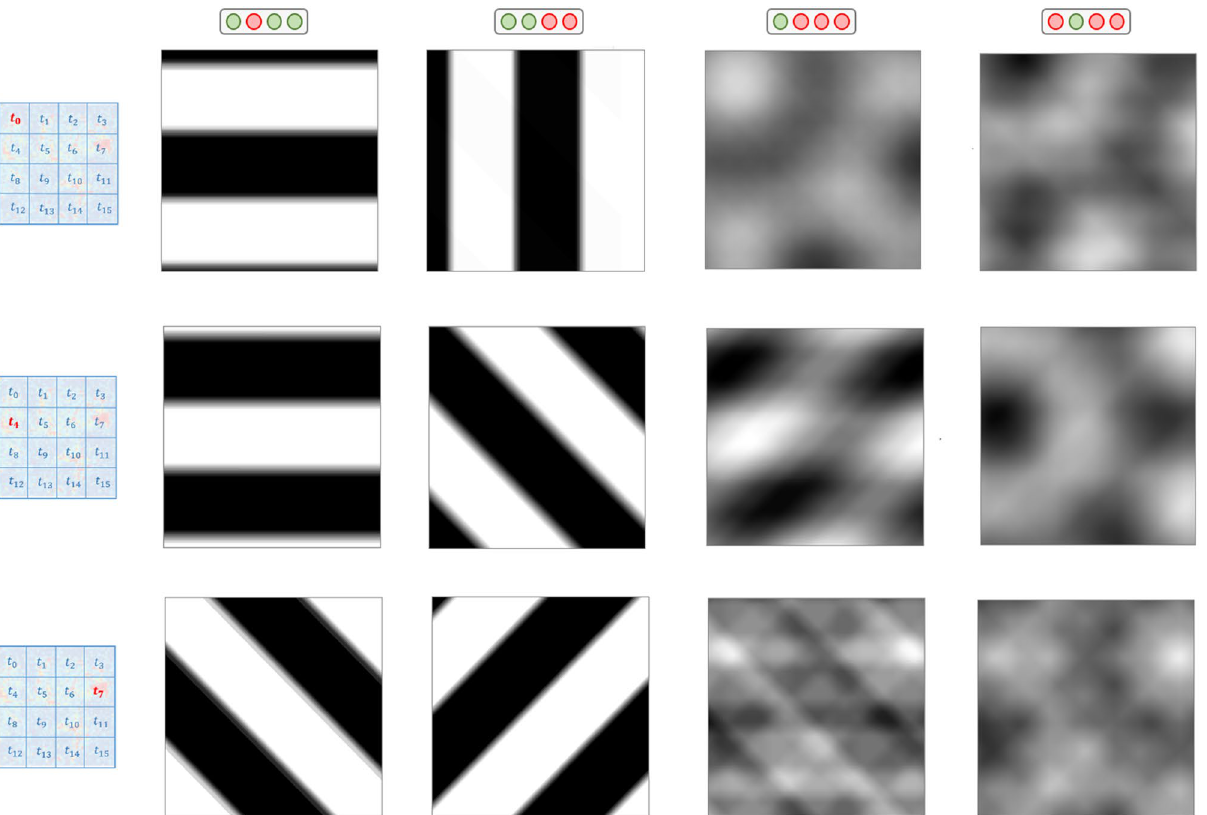
Figure 2. Results related to Experiment 1. Each row is associated with a different patch of the MEA chip, from which neurons were recorded during the experiments. Top-down: patches t0, t4, t7. The first two columns represent averages over stimuli associated with different binary states, the last two columns represent averages over stimuli associated with different binary